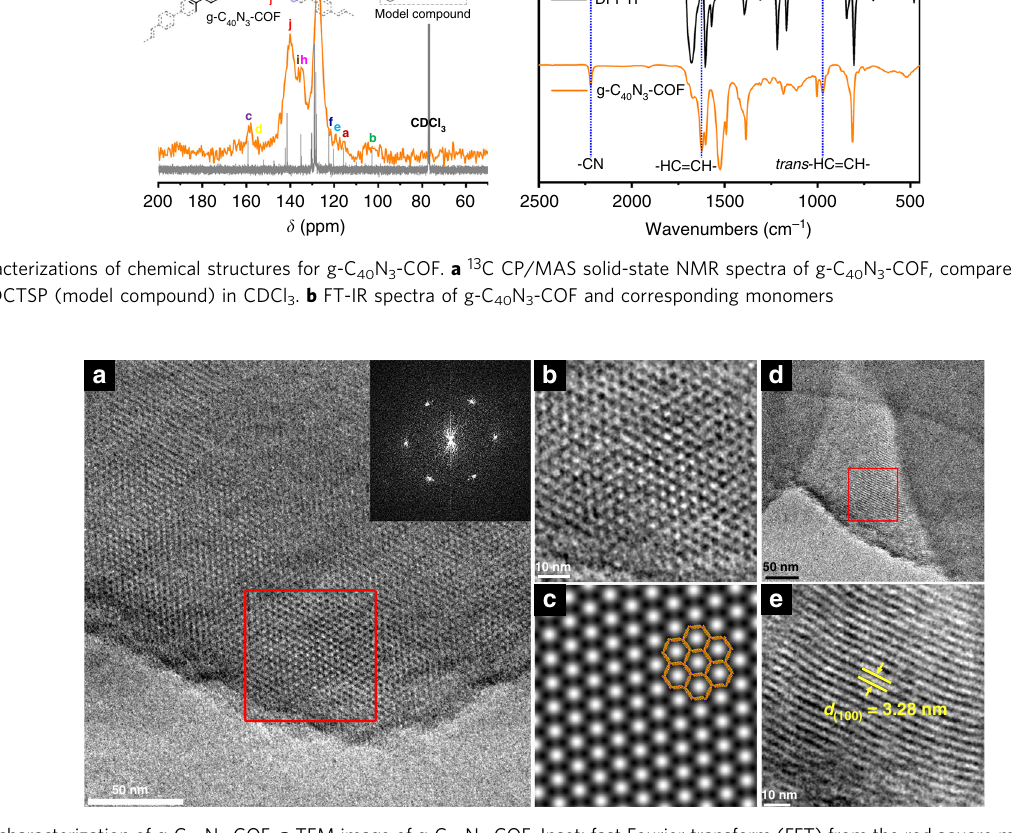
Fig. 4 TEM characterization of g-C 40 N 3 -COF. a TEM image of g-C 40 N 3 -COF. Inset: fast Fourier transform (FFT) from the red square marked area. b high- resolution TEM image of g-C 40 N 3 -COF showing hexagonal pores viewing from [001] direction. c Simulated HRTEM image. The eclipsed structure model of g-C 40 N 3 -COF is overlaid. d TEM image of g-C 40 N 3 -COF from different areas. e Enlarged HRTEM image of red square marked area in d , showing 1D channels viewing from [110] direction with the pore channel diameter determined as 3.28